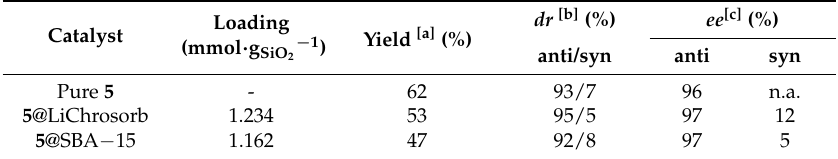
Table 5. Asymmetric aldol reaction carried out by using (4 R )-4-phosphonooxy- L -proline ( 5 ) as a catalyst in solution or immobilized in porous silica materials.